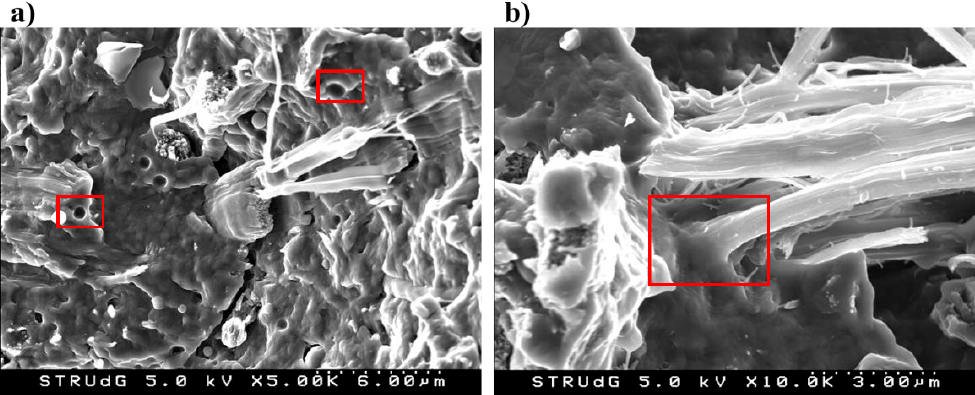
Figure 5. Scanning electron microscopy (SEM) images of the fracture surfaces of the 20 wt % BHF-reinforced PA6 composites. ( a ) voids in the structure of the composite PA6-Hemp fibers; ( b ) interface between fibers and matrix.